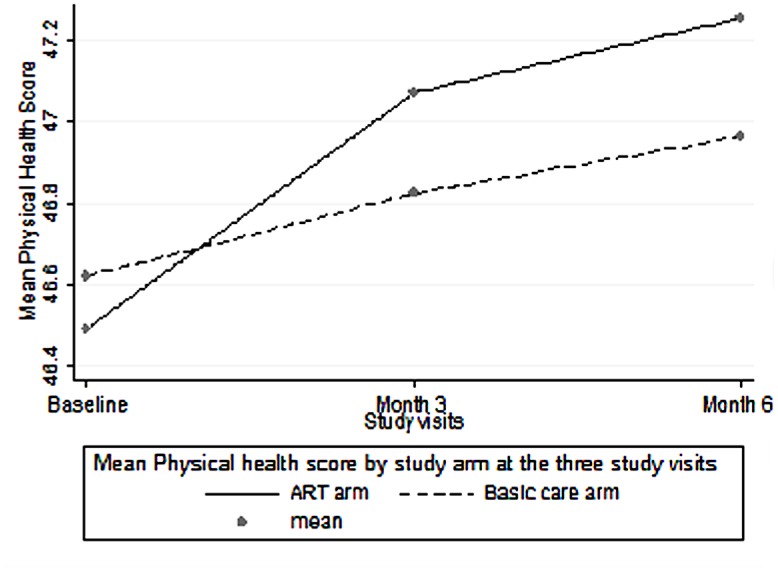
Mean Physical Health Scores over six months.Comparison of Physical Heath Score means ART versus basic care among PLHIV over the follow up period.